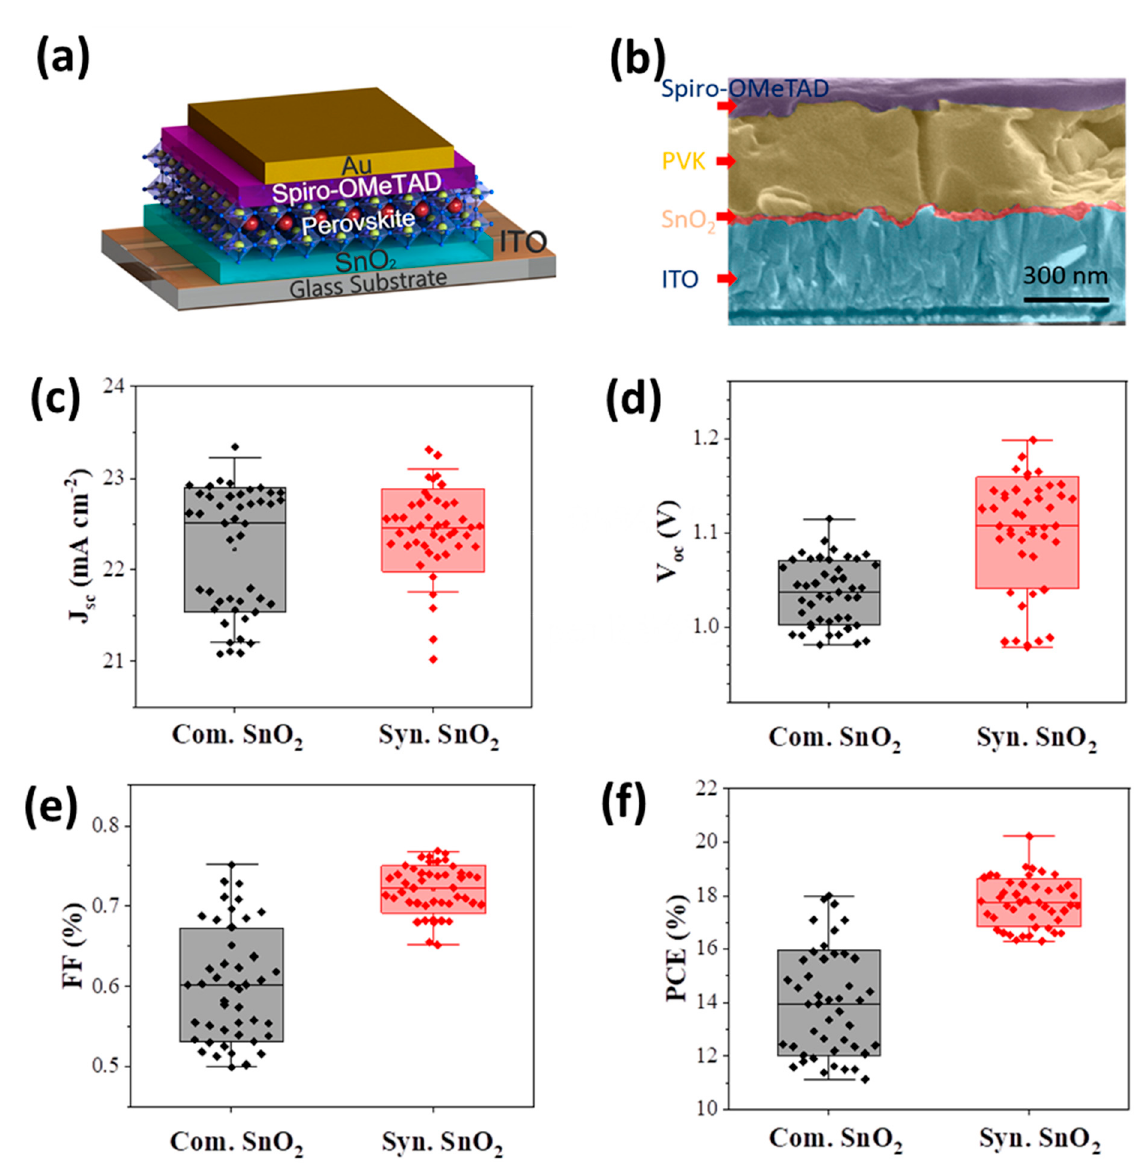
Figure 4. ( a ) Schematic of device structure and ( b ) cross-section SEM image for ITO-glass/SnO 2 /perovskite/Spiro-OMeTAD, ( c ) short-circuit current, ( d ) open-circuit voltage, ( e ) fill factor, and ( f ) PCE of PSCs with spin-coated ETLs based on commercial or synthesized SnO 2 the devices (active area 0.2 cm 2 ).